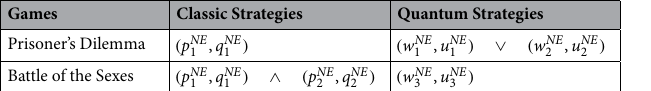
Games Classic Strategies Quantum Strategies